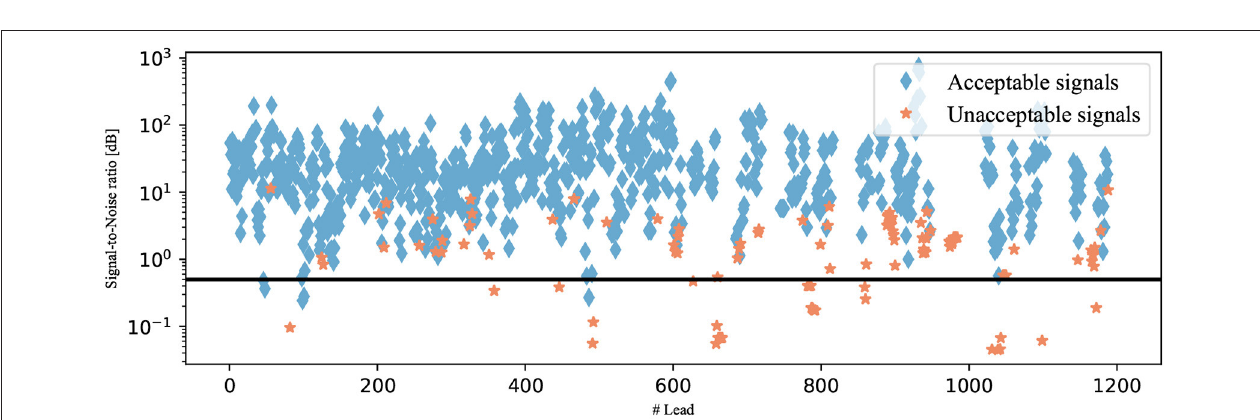
FIGURE 6 | SNRs of the signals from the testing data set. The signals are shown as diamonds if they were annotated as acceptable and as stars if they were annotated as unacceptable. The selected SNR threshold of 0.5 dB is shown as a black line.